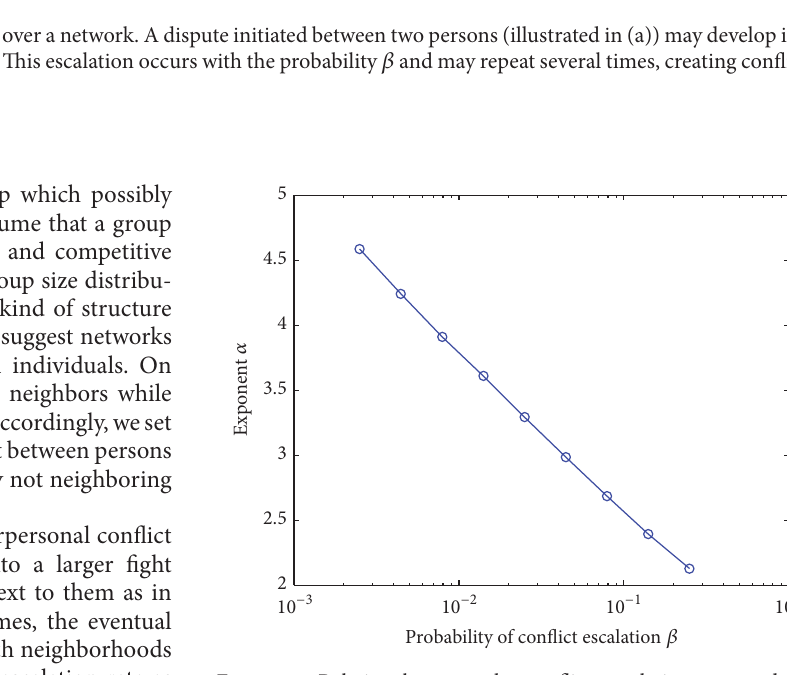
Figure 7: Relation between the conflict escalation rate and the power law exponent of the conflict size for a scale-free network. Once the topology of the network is fixed, the conflict escalation rate 𝛽 determines the distribution of the conflict size as in